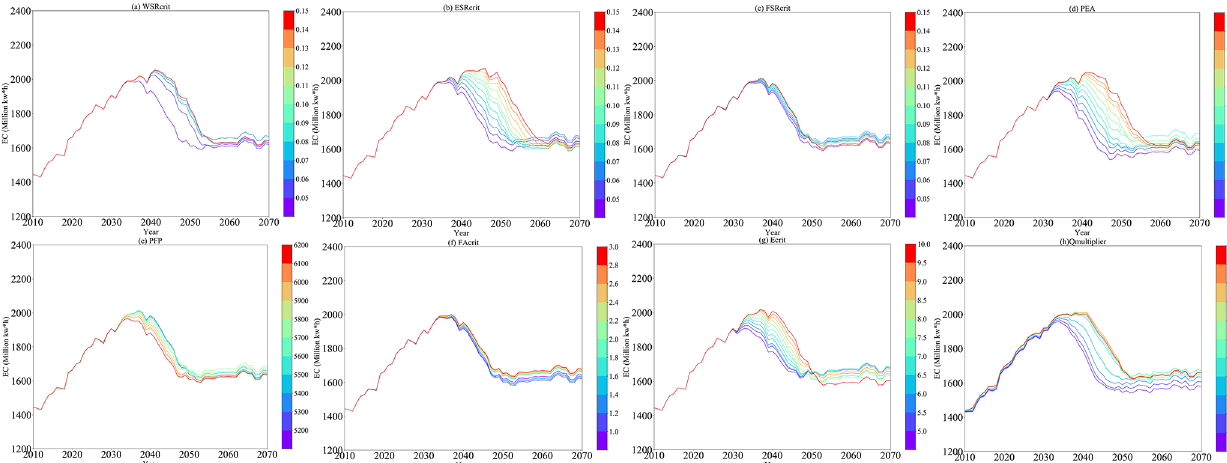
Figure 10. Trajectories of energy consumption with varied parameters.